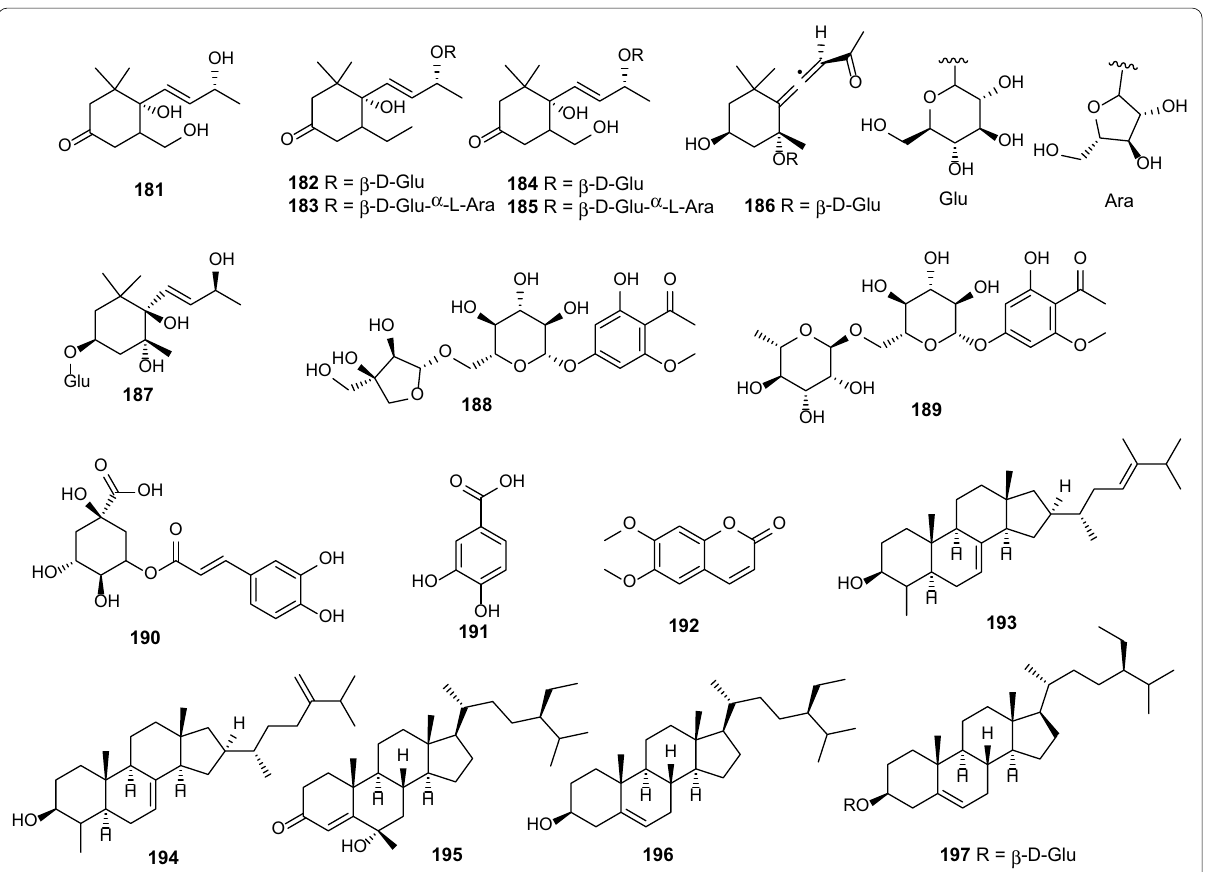
Fig. 8 Chemical structures of other constituents ( 181–197 ) found in Erythroxylum